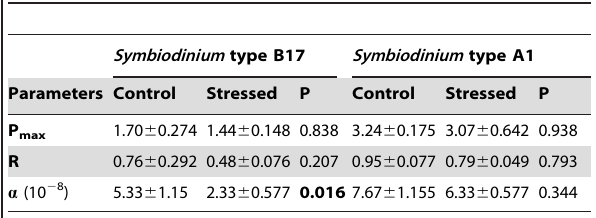
Table 2. Photosynthetic parameters normalized to cell number for Symbiodinium cultured under experimental